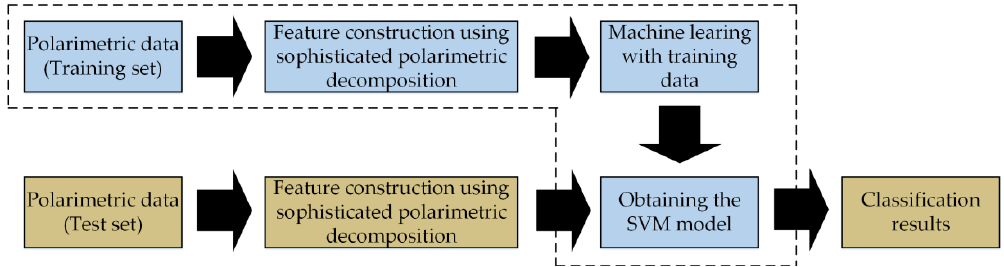
Figure 3. The flowchart of ship recognition based on the support vector machine.